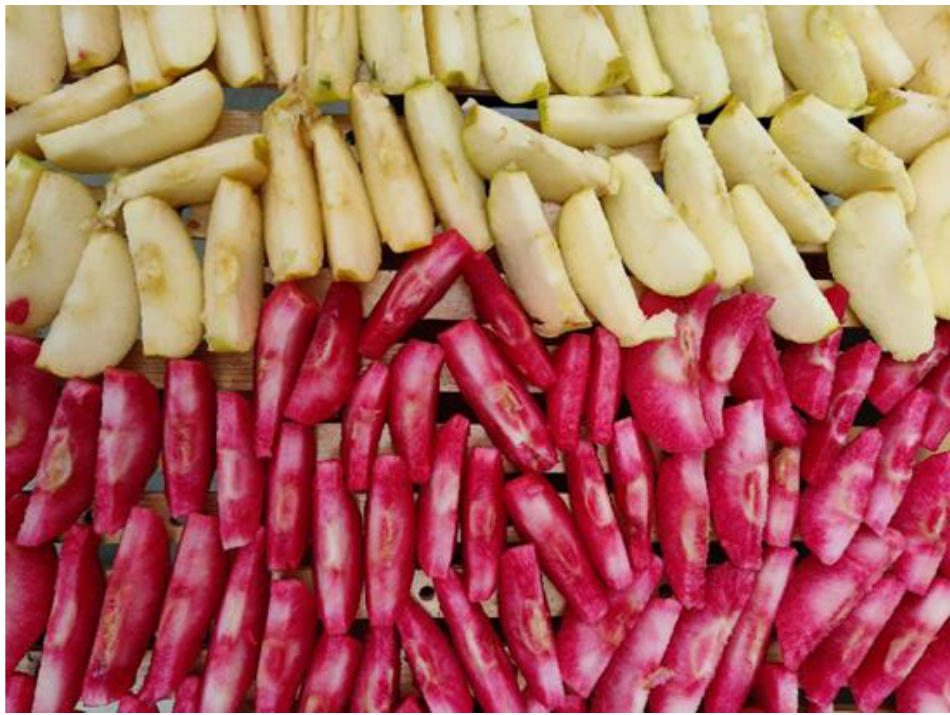
Figure 1 . Apple slices of white-fleshed cultivar ‘Golden Delicious’ (above) and apple slices of red-fleshed cultivar ‘ Baya Marisa ’ (below), prepared for dehydration.